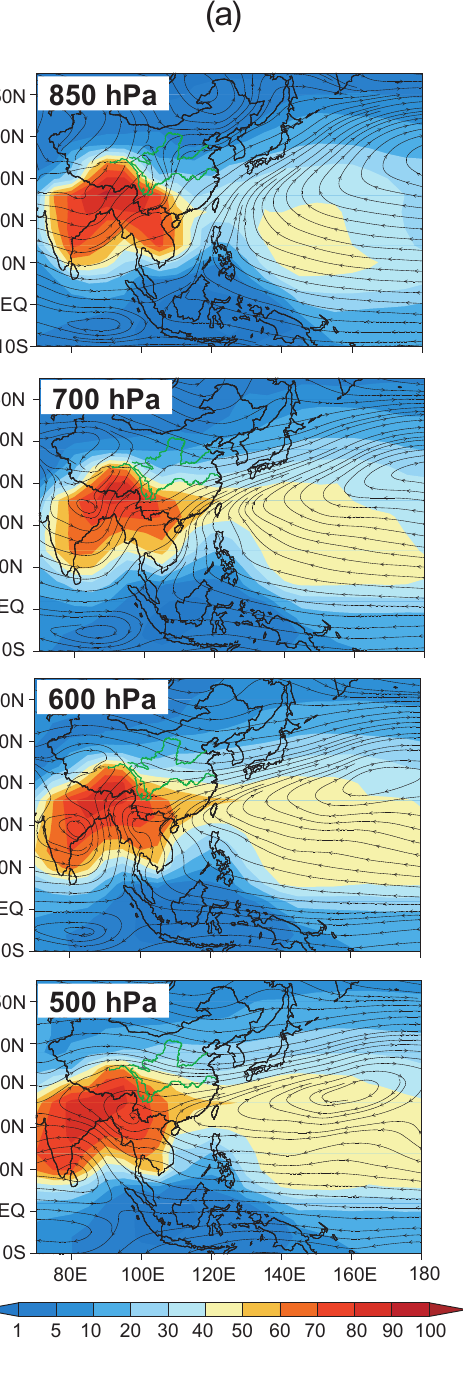
Fig. 5. The summer (JJAS) mean RatiosOC (color shades) and wind stream from 850hPa to 500hPa in (a) 1998 and (b) 2002. Meteorological fields are from the GEOS-4 assimilated